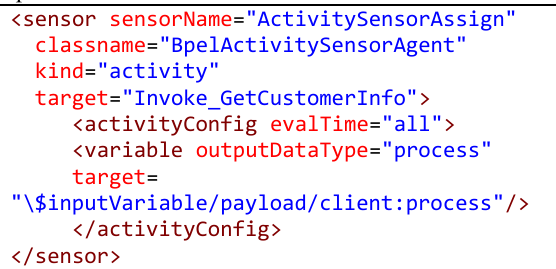
Fig. 15. A simple example of an activity